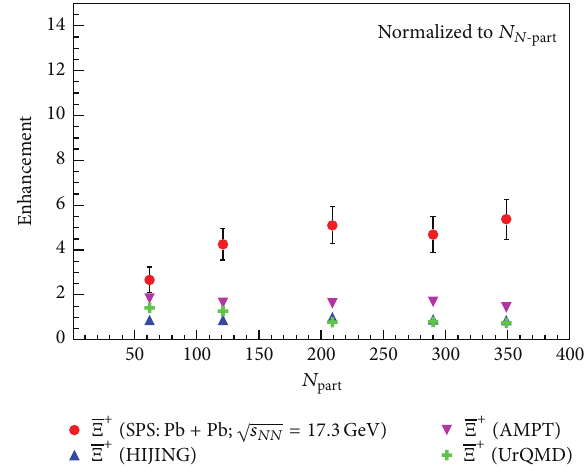
+ as a function of